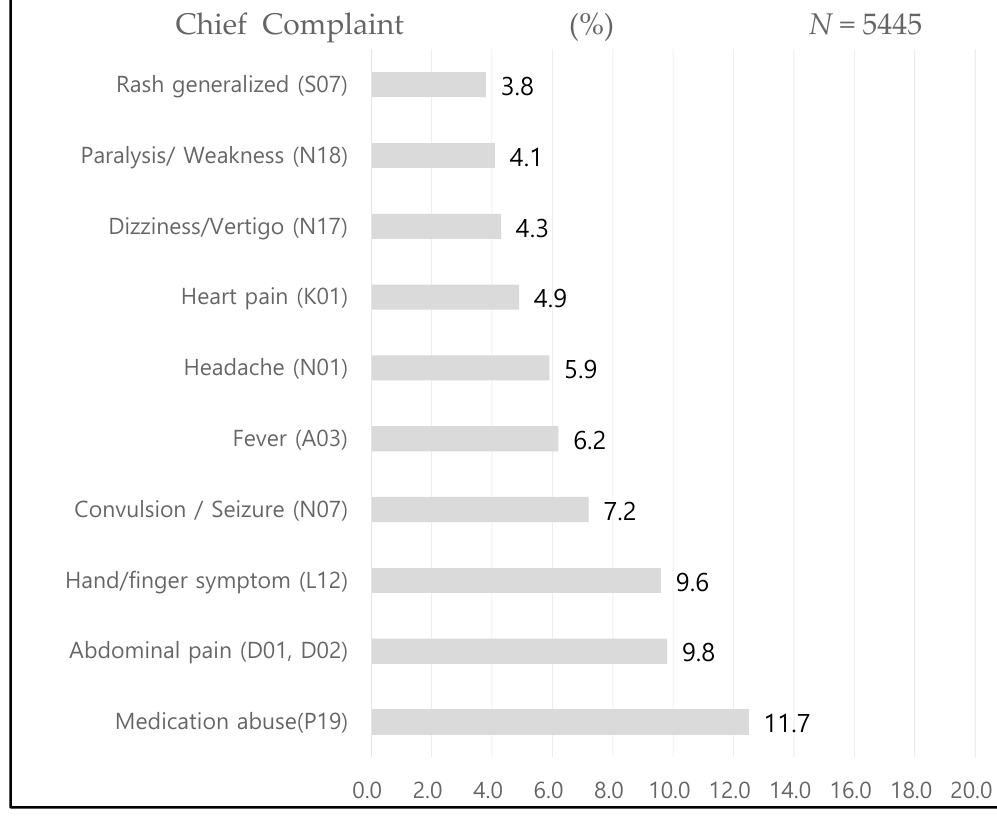
Figure 1. Distribution of the main chief complaints of patients DAMA after their first emergency room visit in this study.